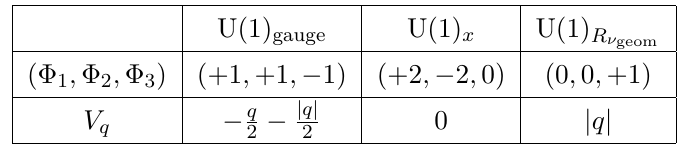
Table 2 . Charge of elementary fields and local operators in T [ m 009 , A SP ; B SP − A SP ]